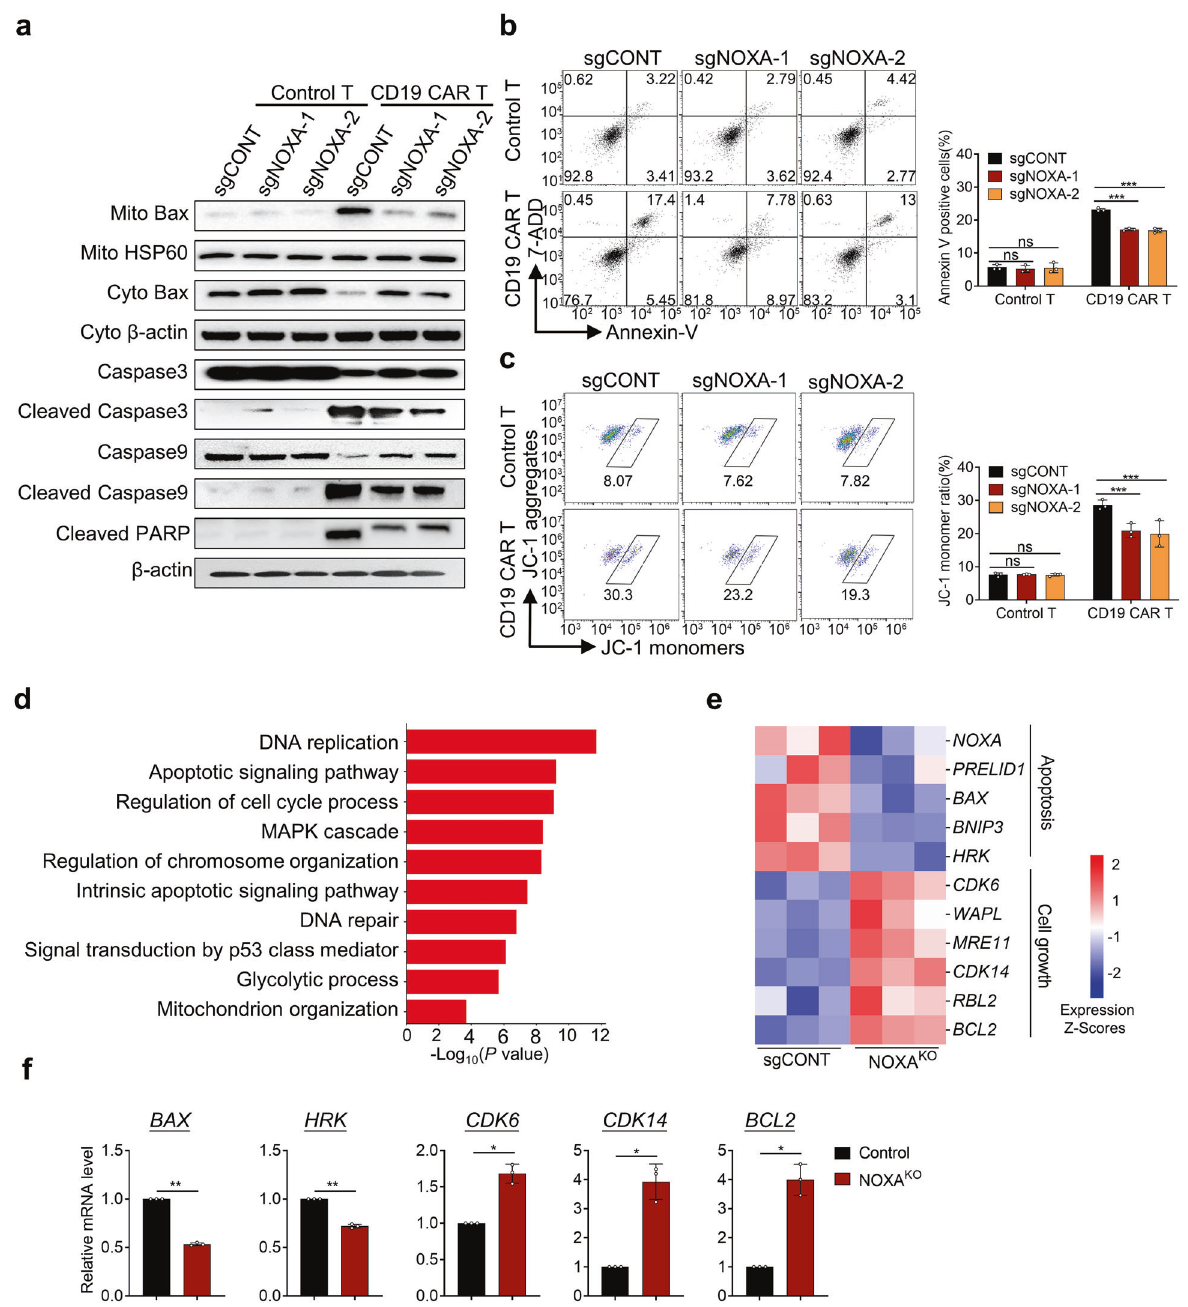
Fig. 3 NOXA knockout induces resistance to CAR T cells via the apoptotic pathway. a sgCONT and NOXA KO Nalm6 cells were treated with control or CD19 CAR T cells before western blotting assays. Mitochondrial protein levels were normalized to HSP60, and the cytosolic protein and total protein levels were normalized to β -actin. b , c sgCONT and NOXA KO Nalm6 cells were collected and stained with Annexin V/7-ADD and JC-1 and analyzed by fl ow cytometry after coculture with control or CD19 CAR T cells. d GO enrichment analysis of differentially expressed genes between sgCONT and NOXA KO Nalm6 cells in biological process functions. e Heatmap of selected genes with differential expression ( P < 0.05) related to apoptosis and cell growth between sgCONT and NOXA KO cells after coculture with CD19 CAR T cells. f BAX , HRK , CDK6 , CDK14 , and BCL2 expression was compared between sgCONTand NOXA KO cells after coculture with CD19 CAR T cells by real-time PCR. Differences among groups were calculated with two-way ANOVA tests. Values are shown as the mean ± SD of triplicates. ns: not signi fi cant ( P > 0.05); * P < 0.05, ** P < 0.01, and *** P < 0.001